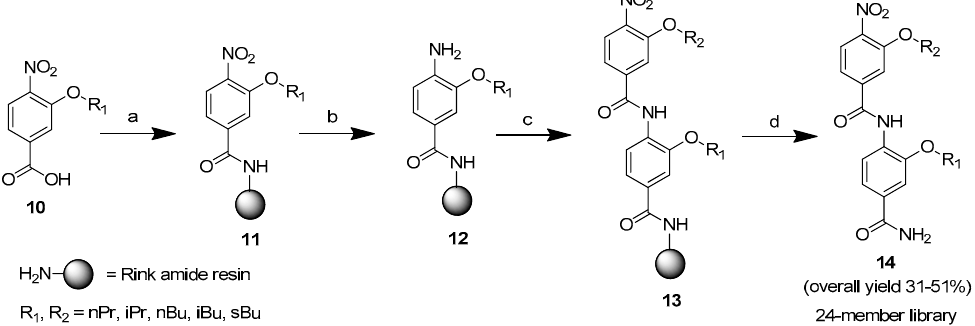
Table 1. Antiproliferative activity of bis-benzamides a .